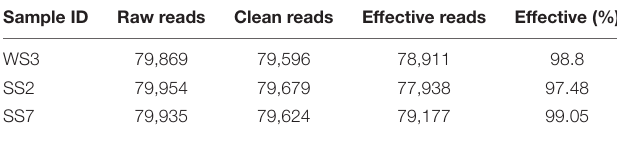
TABLE 1 | The data of 18S rDNA high-throughput